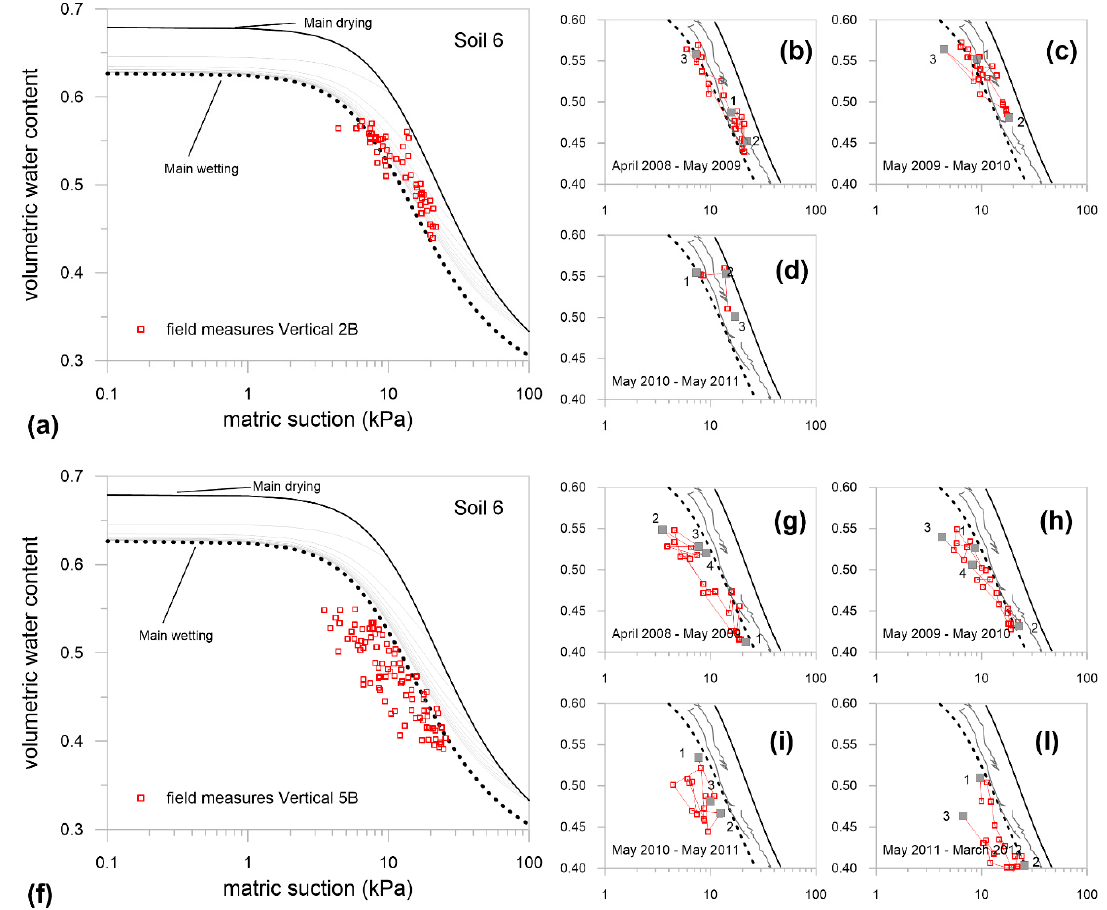
Figure 14. Pairs of matric suction and water content measurements collected at site in soil 6 along verticals ( a ) 2B and ( f ) 5B compared to the main loop (continuous and dotted black lines) and to the secondary wetting paths starting from different points on main drying curve (gray dotted lines). Field paths grouped by year and detected at vertical 2B ( b) –( e ) and at vertical 5B ( g) –( l ) compared to the experimental path measured in the physical model during the third monitoring year.